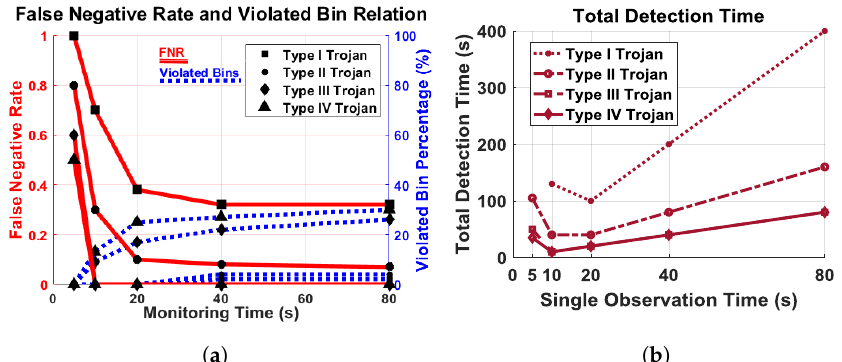
Figure 11. ( a ) Relation of False negative rate (FNR) (red) and minimum number of violated bin (blue) with respect to monitoring time. There are no false positives; ( b ) total time to detect malicious activity with respect to single observation